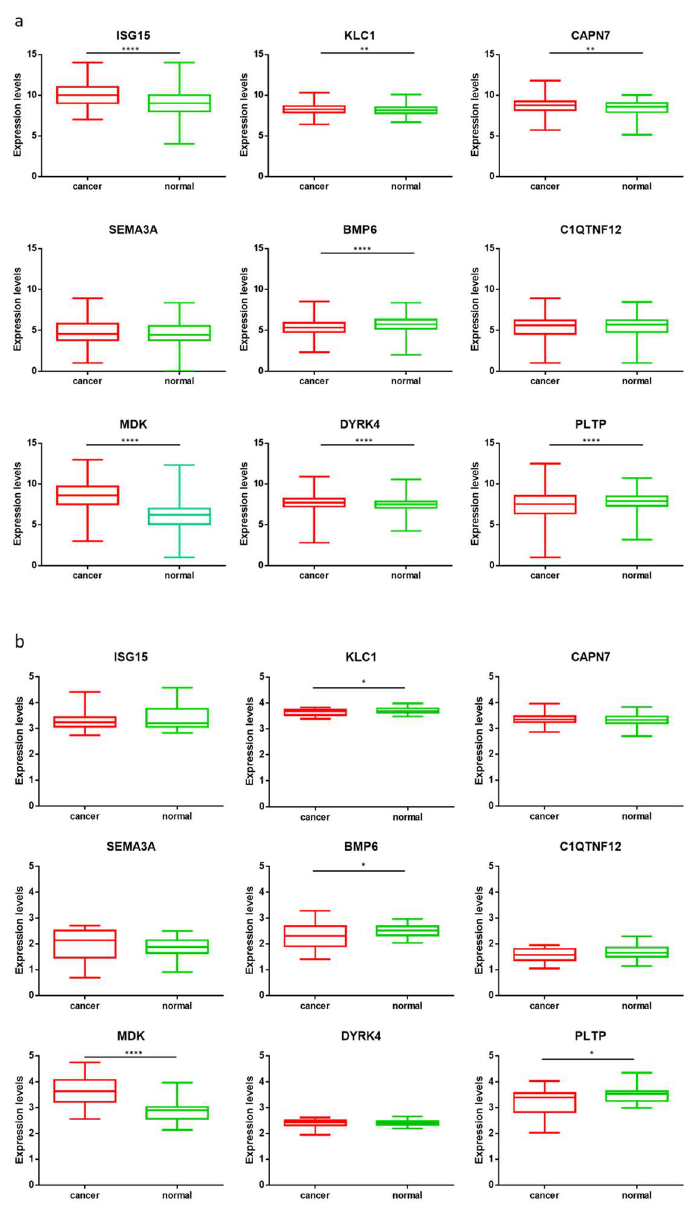
Figure 3. Gene expression levels in tumoral and nontumoral liver tissue: ( a ) transcript levels of 9 HSP-pp from 24 HCC patients; ( b ) transcript levels of 9 HSP-pp from GENT2 database. p < 0.0001 (****); p < 0.05 (**); p < 0.01 (*).